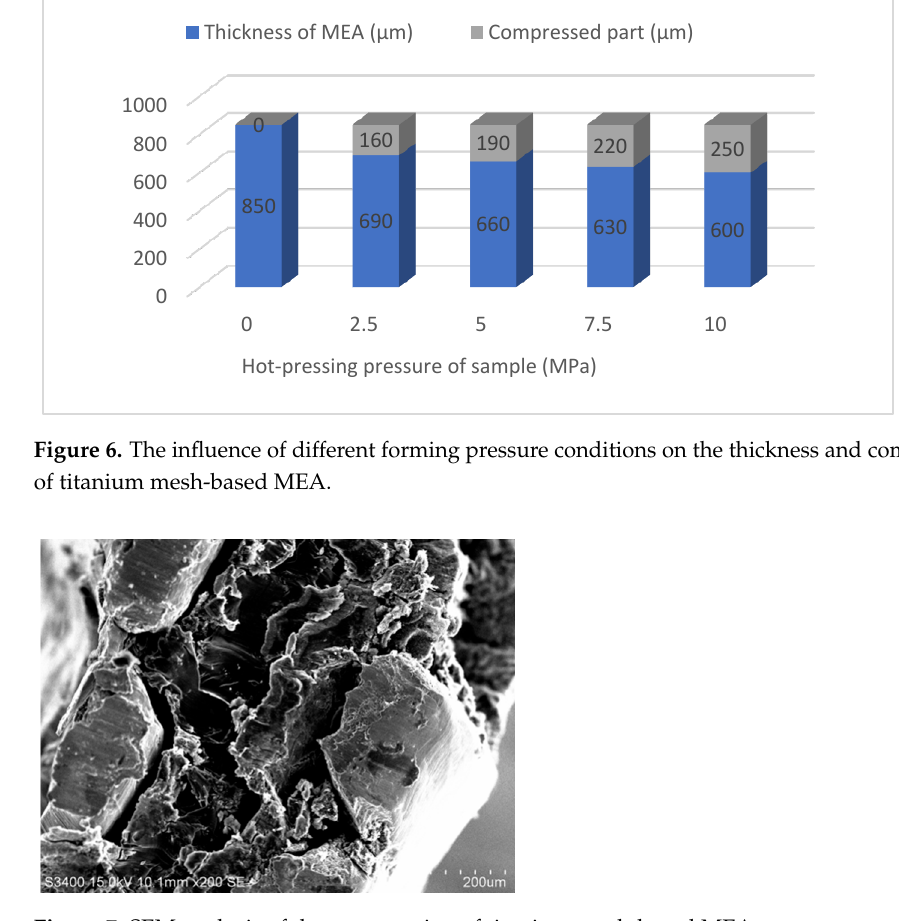
Figure 6. The influence of different forming pressure conditions on the thickness and compressibil- ity of titanium mesh-based MEA.